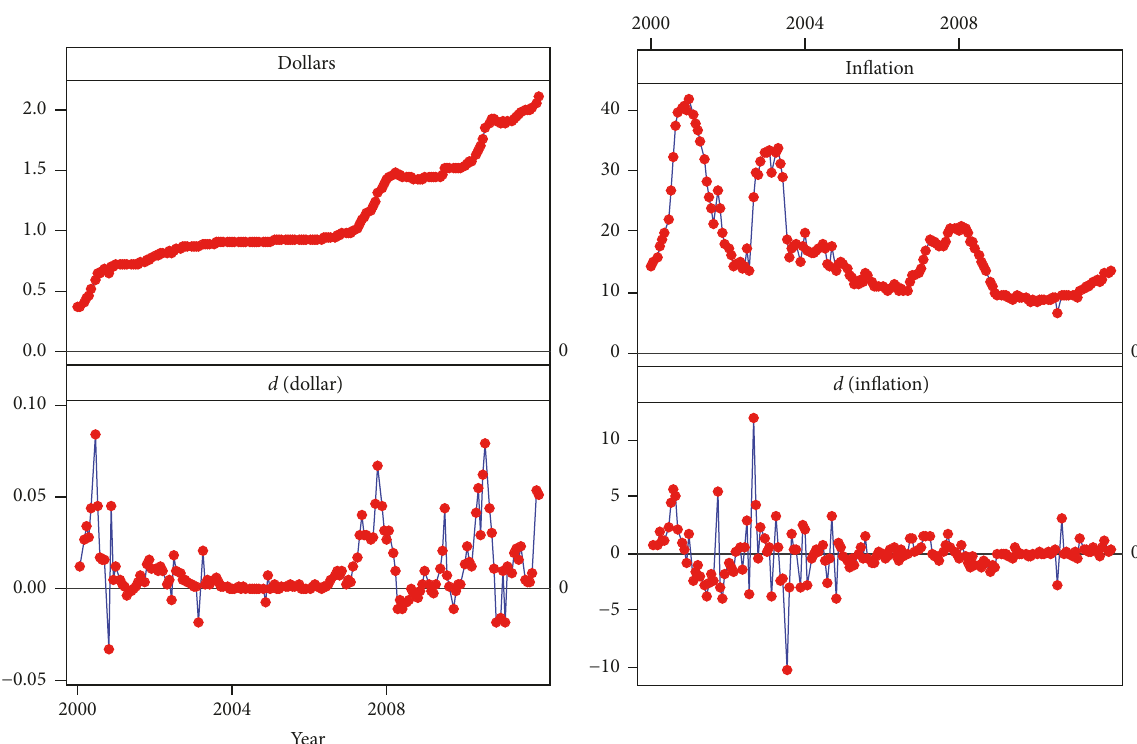
Figure 2: Time series plot of monthly inflation, exchange rate, and their first difference.